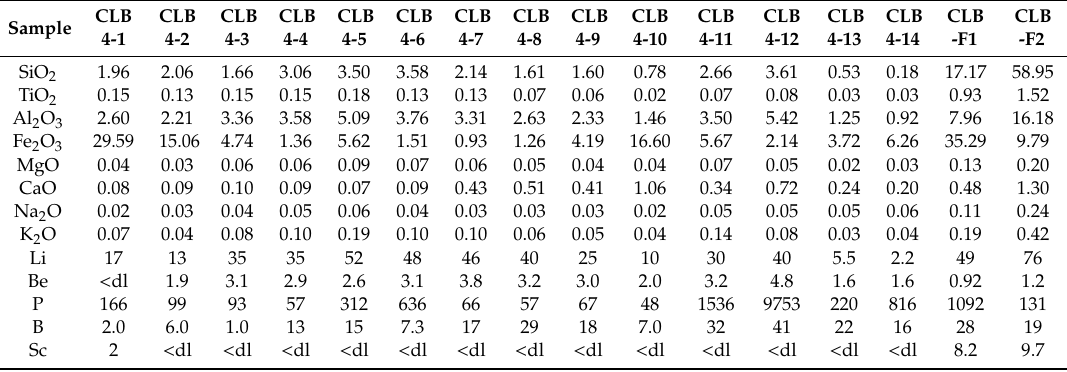
Table 4. Major-element oxides (%) and trace element concentrations ( µ g / g) of the coal and floor samples from the Chalinbao underground coal mine in the Tongzi Coalfield (on whole-coal basis). CLB Sample